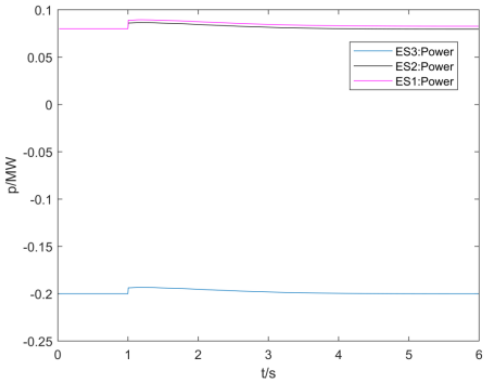
Figure 16. Discharge characteristics of each energy storage (consider VSG only).